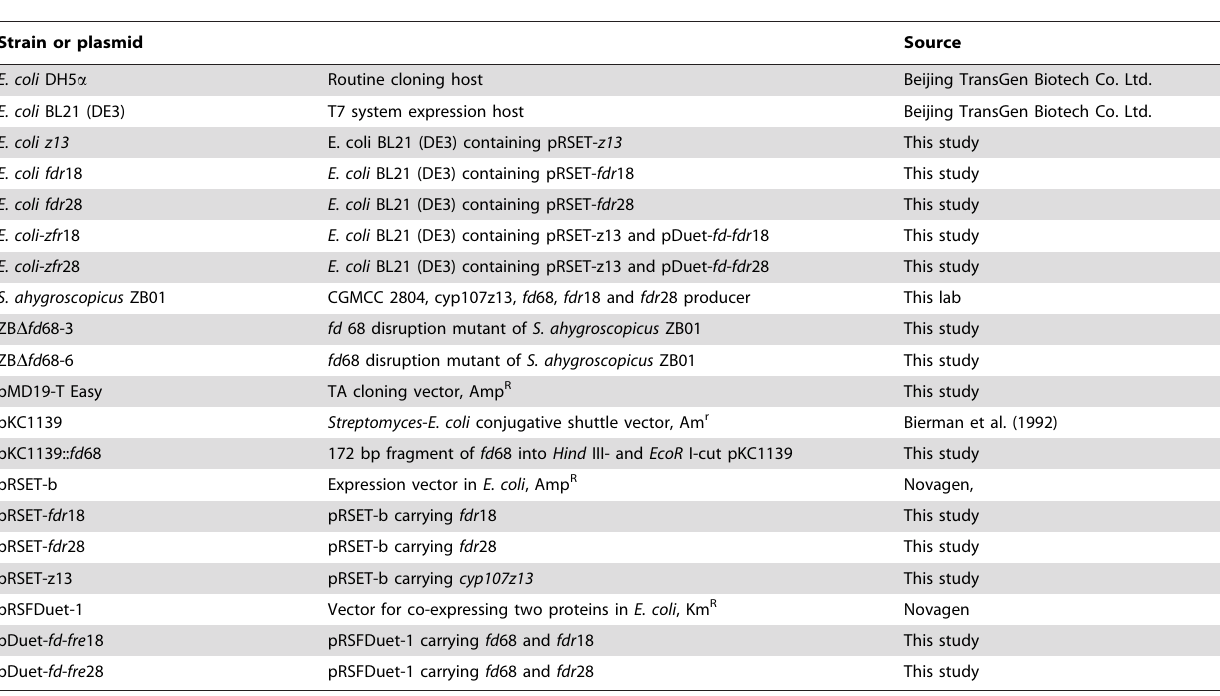
Table 1. Microoganisms and plasmids used in this study.